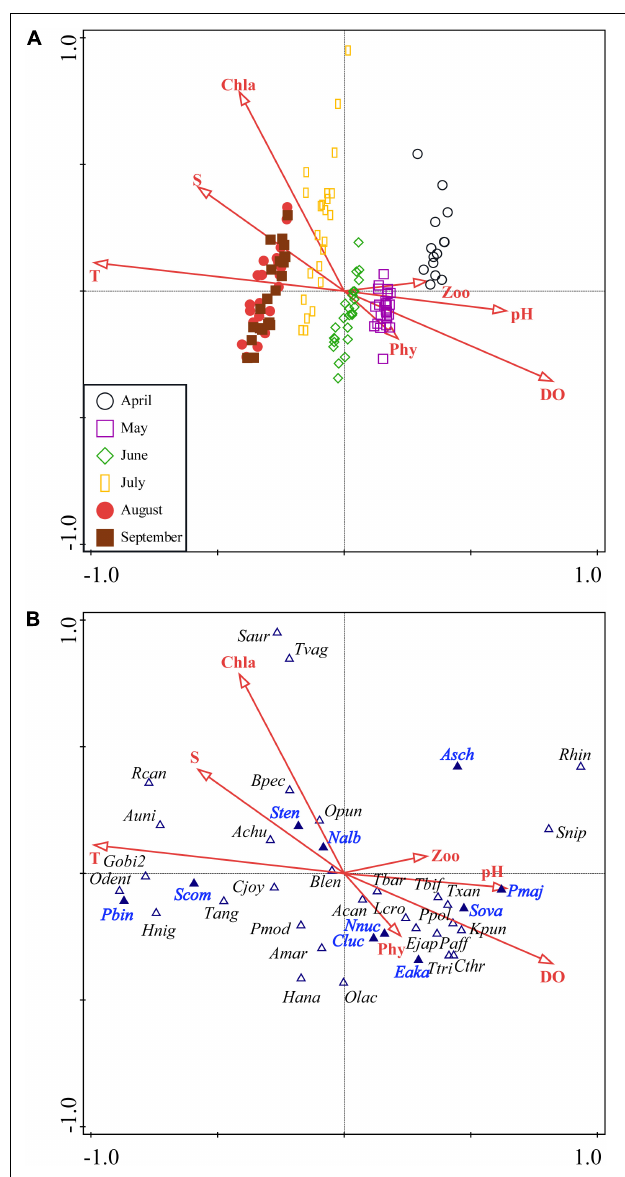
FIGURE 7 | Canonical correspondence analysis (CCA) diagram for ichthyoplankton assemblages (A) and species (B) with abiotic and biotic factors in Sansha Bay of Fujian Province, China. The abbreviations in panel (B) are species names shown in Supplementary Table 1 . The dominant species are shown in blue and bold. Sten, Setipinna tenuifilis ; Scom, Stolephorus commersonnii ; Sova, Solea ovata ; Eaka, Epinephelus akaara ; Nnuc, Nuchequula nuchalis ;, Pbin, Photopectoralis bindus ; Cluc, Collichthys lucidus ; Nalb, Nibea albiflora ; Asch, Acanthopagrus schlegelii ; Pmaj, Pagrus major ; T, temperature; S, salinity; DO, dissolved oxygen; Chla, chlorophyll a ; Phy, phytoplankton; Zoo,